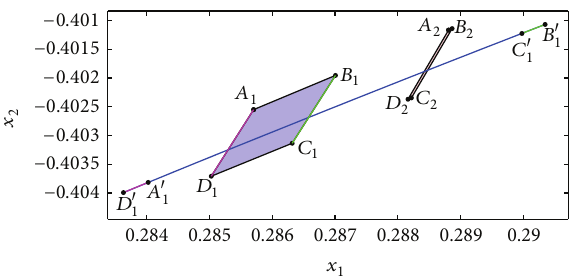
Figure 7: The image 𝜋(|𝐴 1 𝐵 1 𝐶 1 𝐷 1 |) lies wholly across |𝐴 1 𝐵 1 𝐶 1 𝐷 1 | and |𝐴 2 𝐵 2 𝐶 2 𝐷 2 |